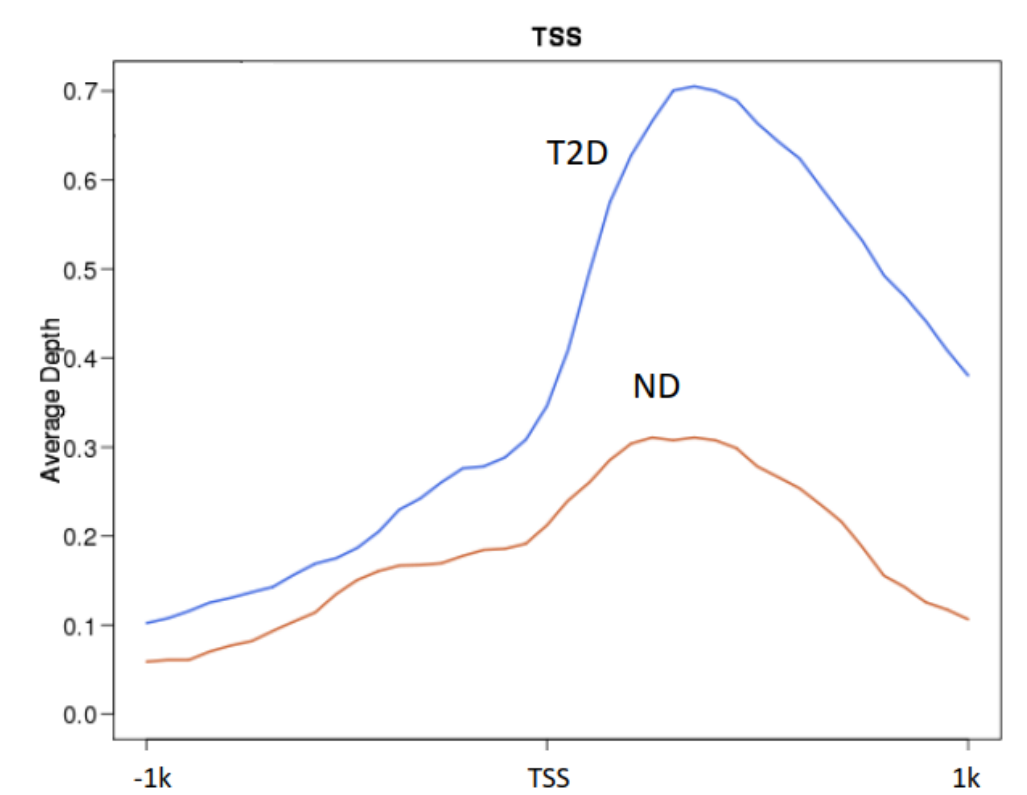
Figure 1. H3K9ac is redistributed in atherosclerosis patients with T2D. ( A ) Bar plot of total number of H3K9ac peaks. ( B ) Venn diagram of peak overlapping between ND (red) and T2D (blue). ( C , D ) H3K9ac enrichment at ( C ) TSSs ( ± 1 kb) of constitutive peaks; ( D ) TSS ( ± 1 kb) where no peak was detected.